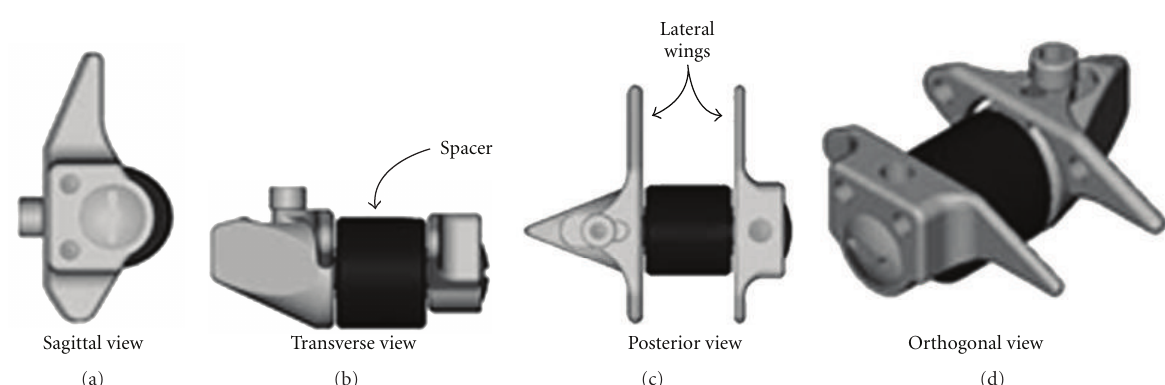
Figure 20: The Wallis implant.